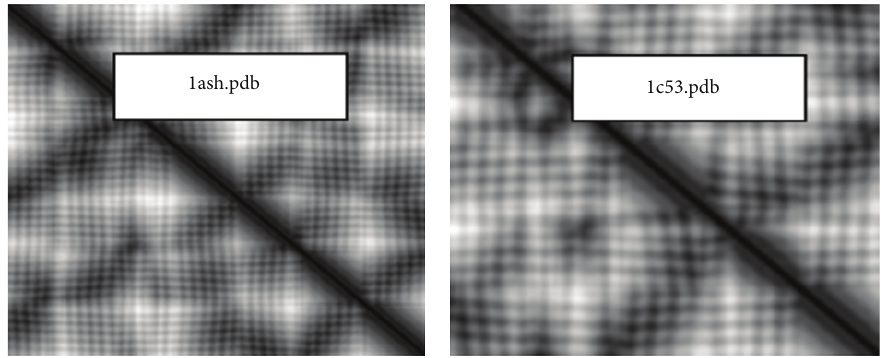
Figure 2: DM images extracted from 2 sample proteins of the DNA